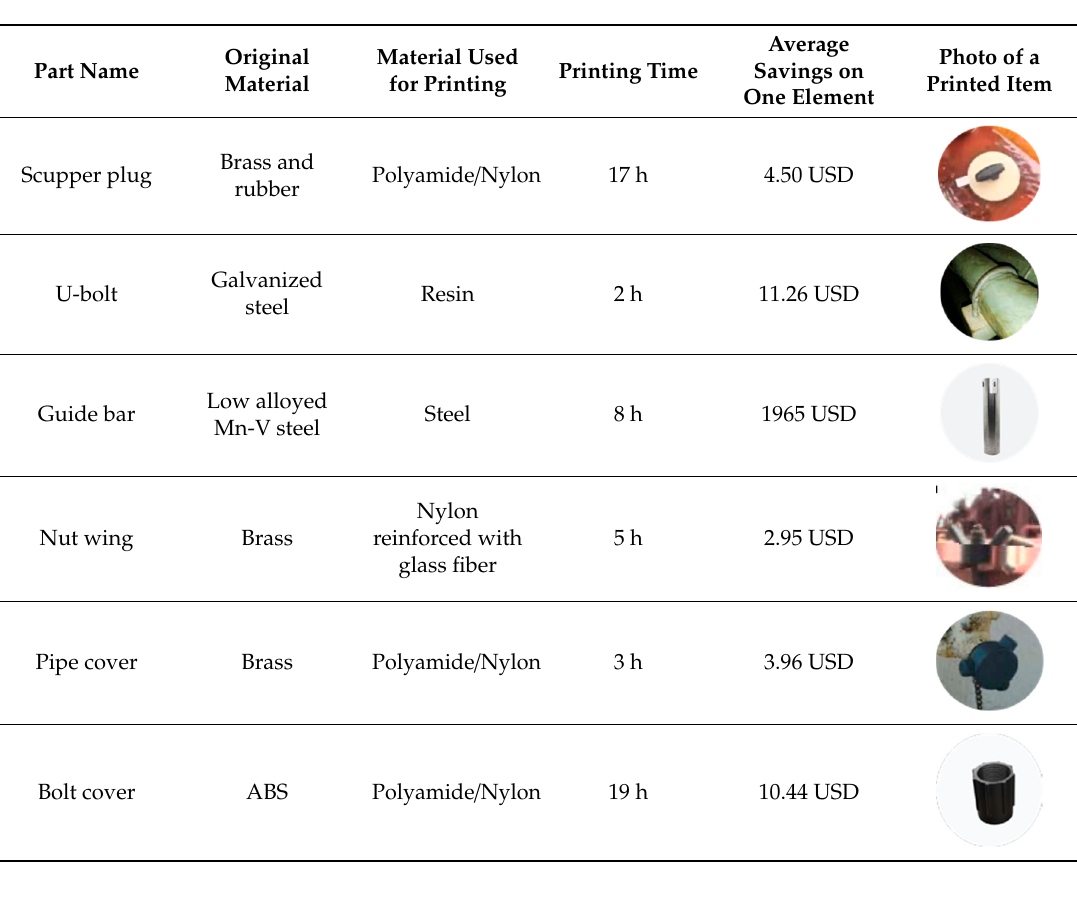
Table 4. Examples of 3D printed elements, production times and savings [43].